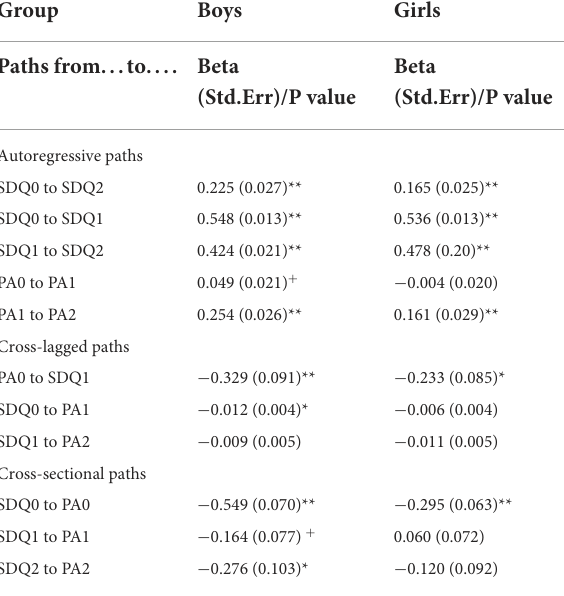
TABLE 3 Significant paths coefficients of Model 3 between PA and SDQ-Total. Group Boys